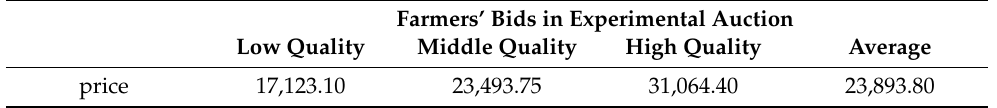
Table 7. Summary of calculation results (Unit: